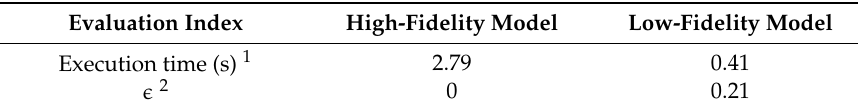
Figure 8. High- and low-fidelity model design for the discrete event system: Example of an urban transportation vehicle (UTV) routing simulation. Table 2. Execution times and errors of high- and low-fidelity models for the urban transportation vehicle (UTV) routing simulation.